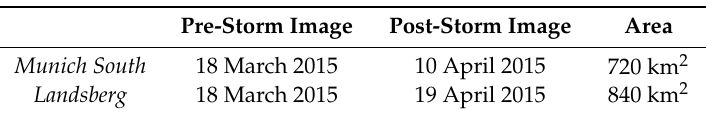
Table 2. Main characteristics of the acquired RapidEye data used to detect windthrow areas caused by